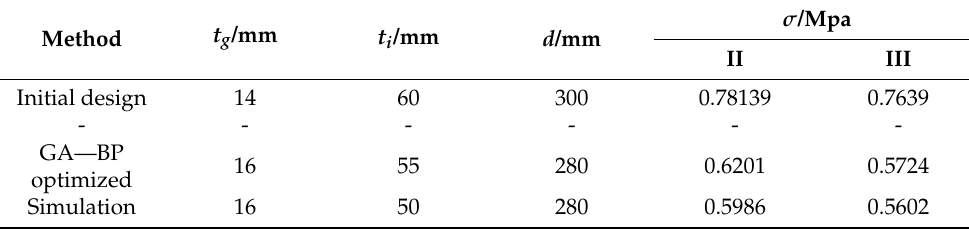
Table 4. Comparison of the optimization results and finite element calculation